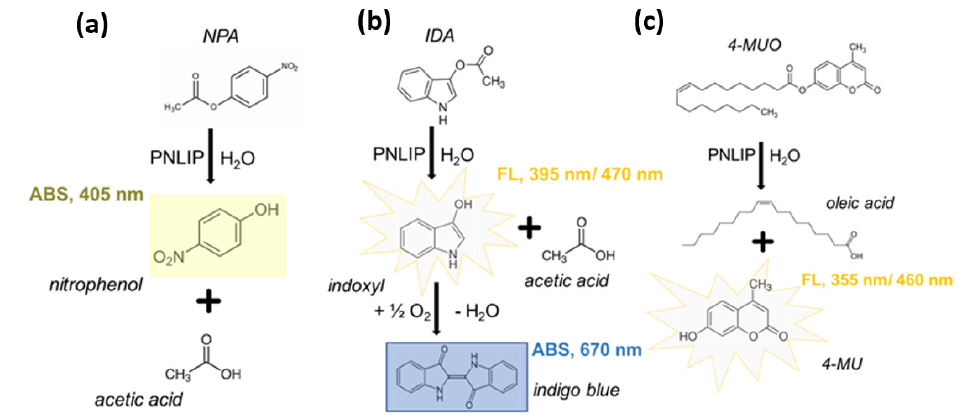
Figure 6. In vitro hydrolysis of ( a ) NPA, ( b ) IDA, and ( c ) 4 − MUO by PNLIP, resulting in both colored and fluorescent products.